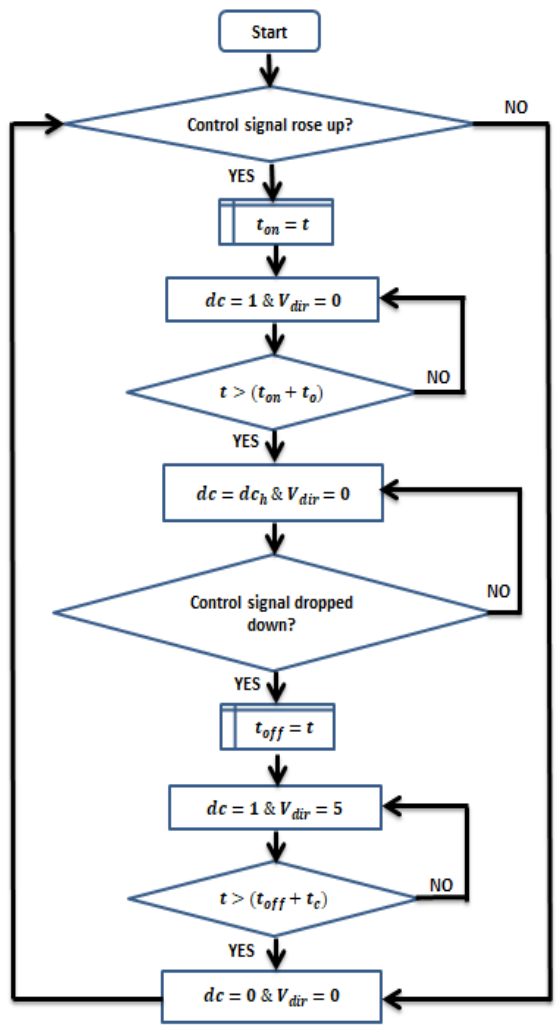
Figure 5. Control method flow